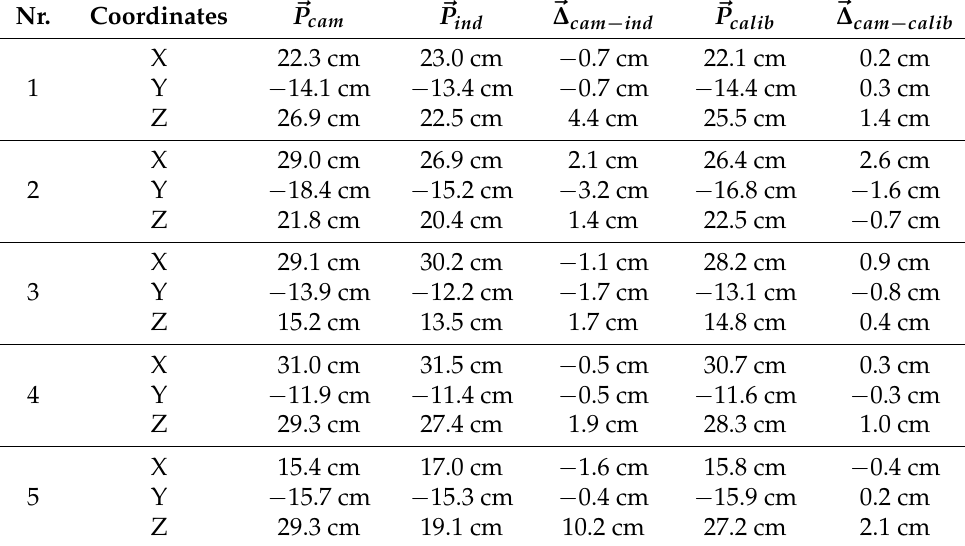
Table 2. Real positions, measured transmitter-positions, and tuned transmitter-positions.